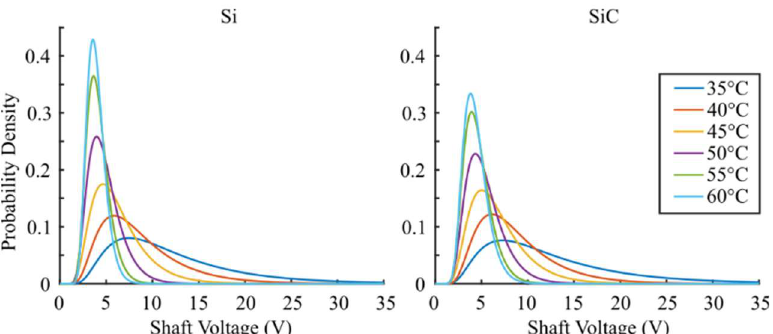
Figure 18. Si and SiC inverter shaft breakdown voltage inverse Gaussian distributions for various bearing operational temperatures. Table 4. Summary of mean ( µ ) and shape ( λ ) parameters for shaft discharge voltage inverse Gauss- ian distributions over various bearing operational temperatures.